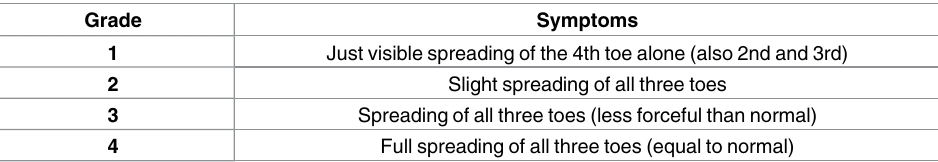
Table 1. The toe-spreading index for behavioral analyses. Grade Symptoms 1 Just visible spreading of the 4th toe alone (also 2nd and 3rd) 2 Slight spreading of all three toes 3 Spreading of all three toes (less forceful than normal) 4 Full spreading of all three toes (equal to